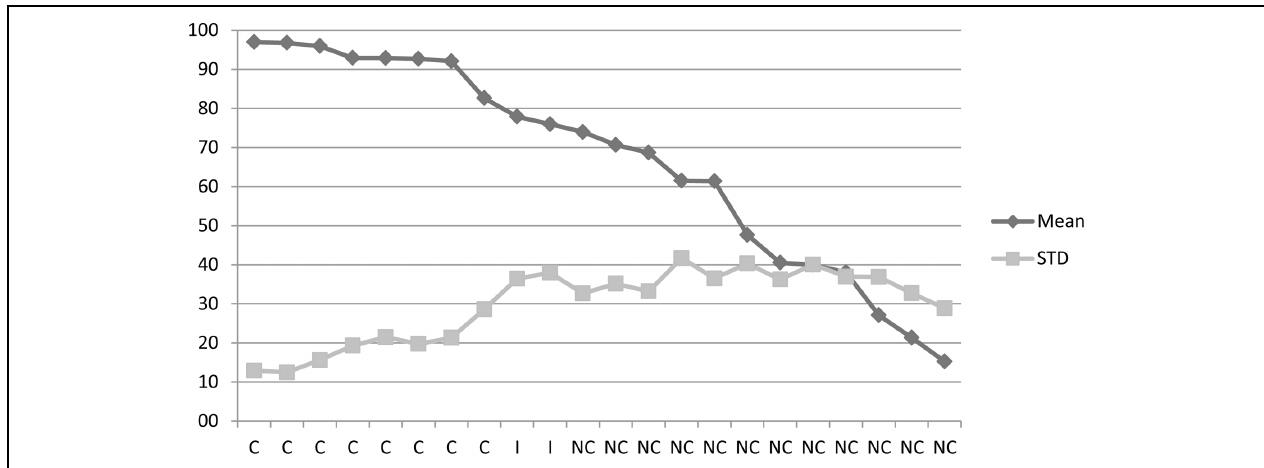
FIGURE A1 | Means and standard deviations for the answerability judgments on the current answerability scale. The standard deviation reflects the variability of each response for each individual across the sample of individuals. Consensus questions are marked with “C”, Non-consensus questions with “NC”, and Illusion questions with